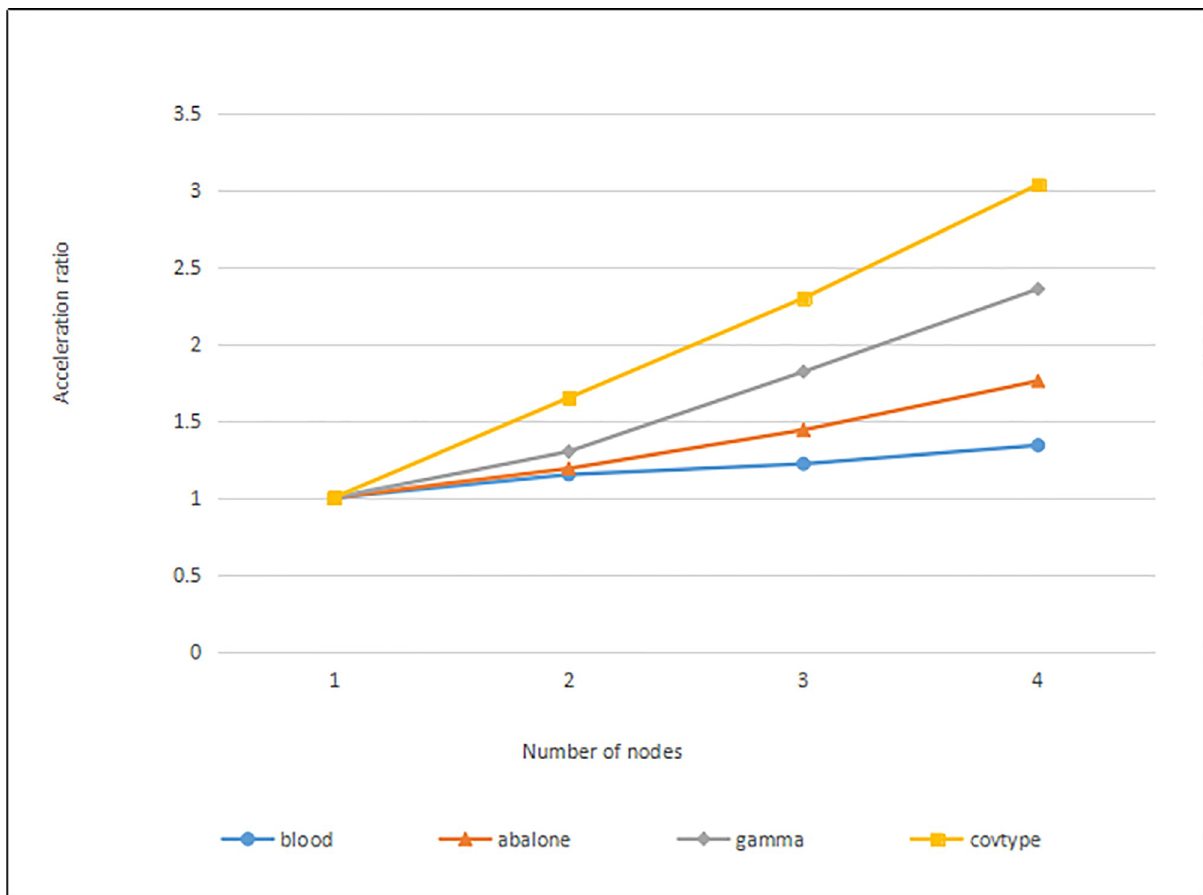
Fig 7. Parallel the algorithm in this paper acceleration